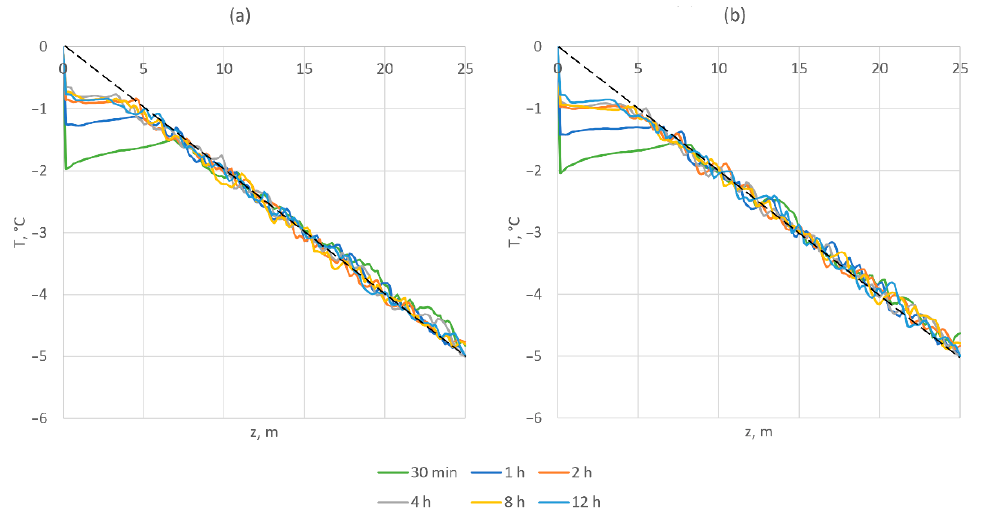
Figure 5. Temperature distributions along the borehole axis at different times at different concentrations of CaCl 2 in the solution: 15% ( a ) and 25% ( b ).